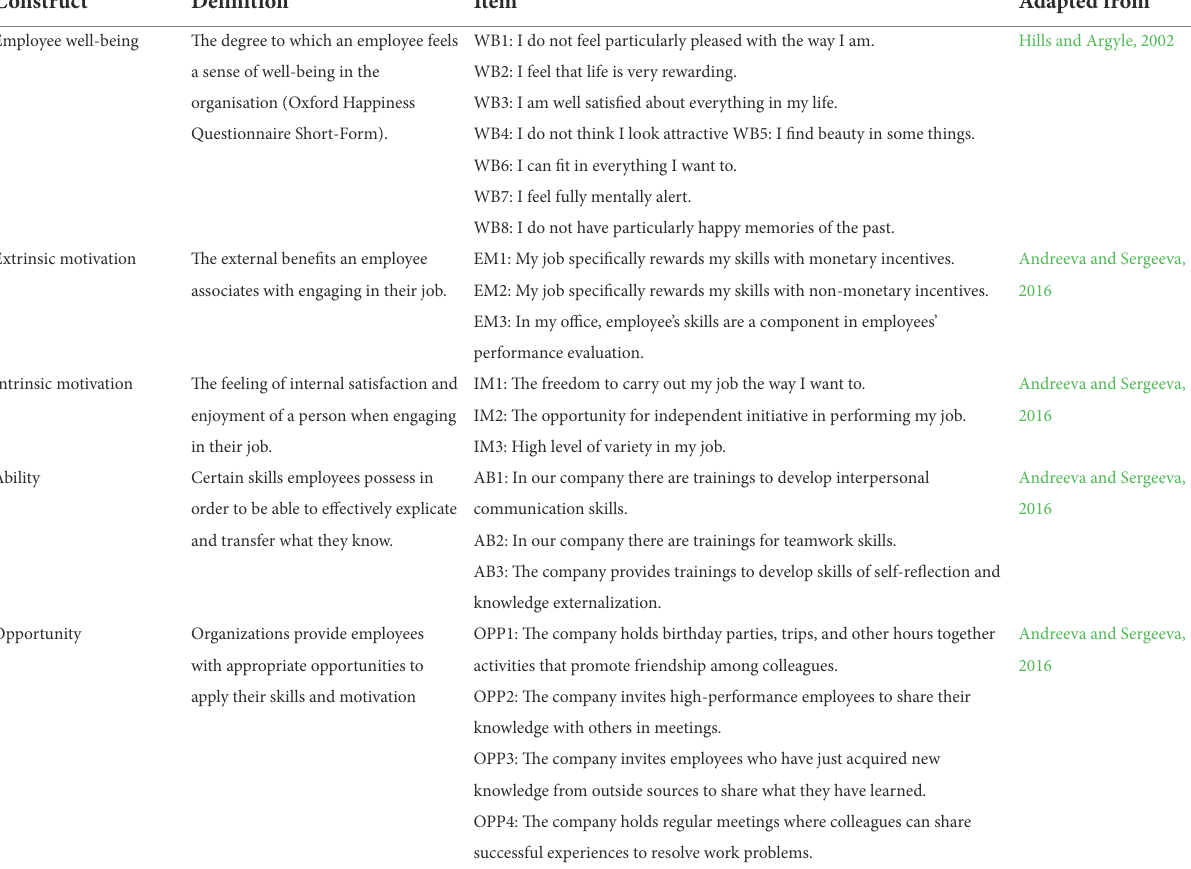
TABLE 1 Constructs/items used in the research’s